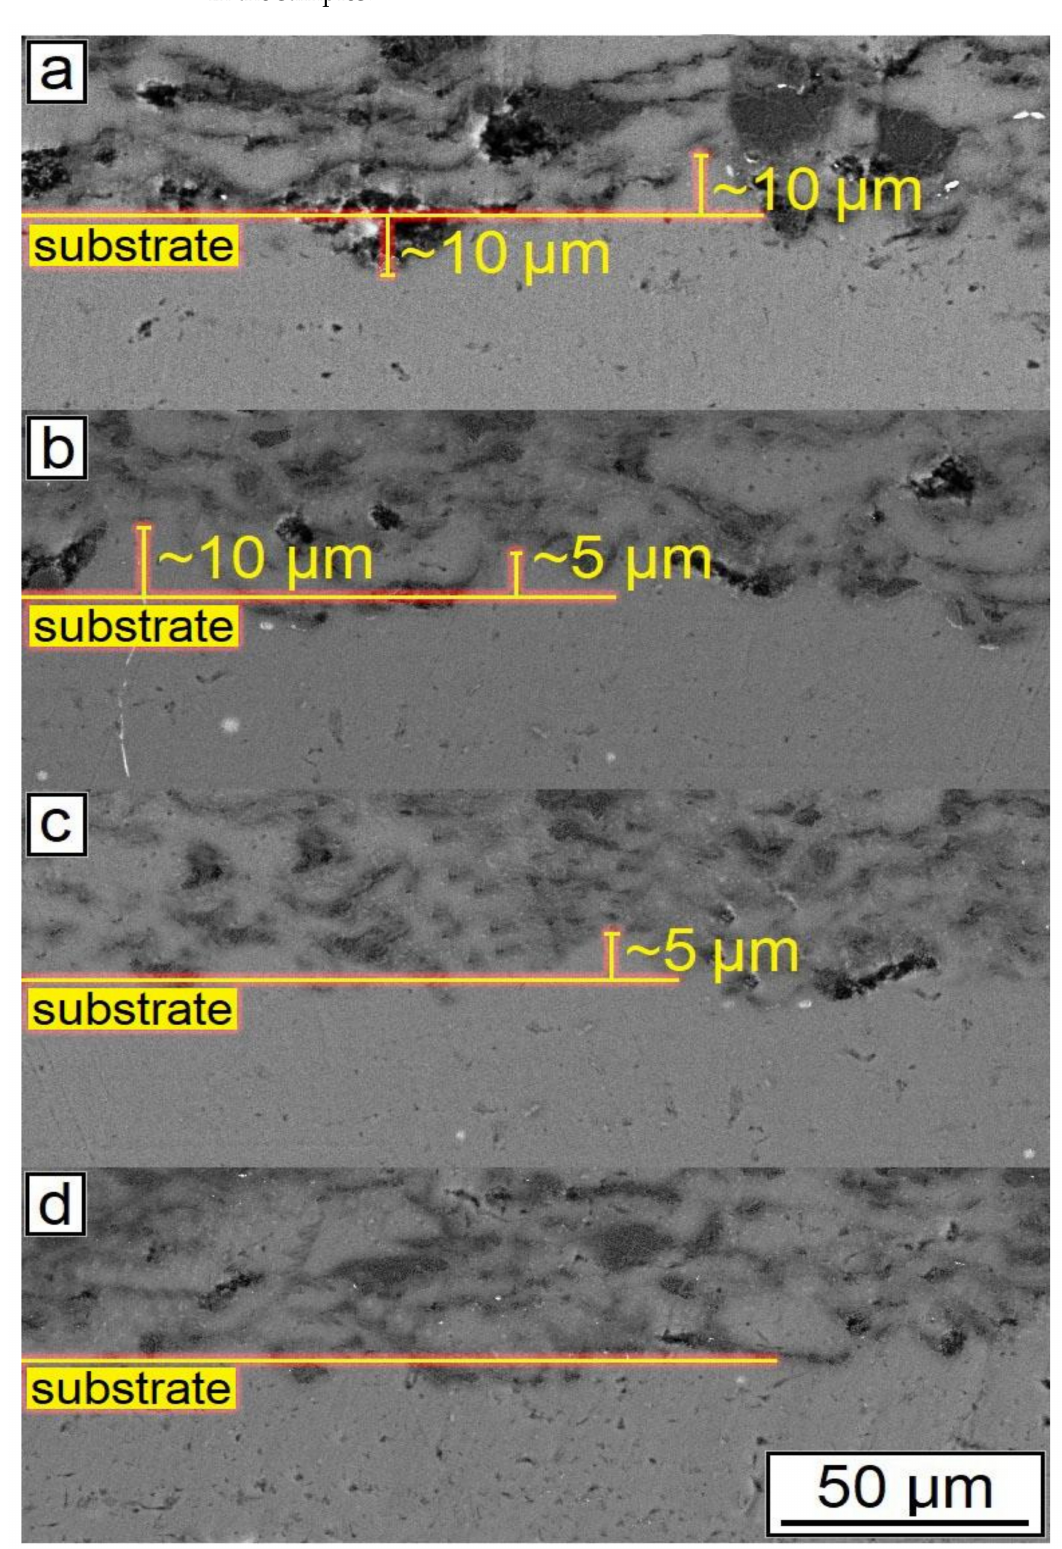
Figure 7. SEM results of the synthesized samples: ( a ) 30% Al + 70% Al 2 O 3 ; ( b ) 29.5% Al + 70% Al 2 O 3 + 0.5% CNF; ( c ) 29% Al + 70% Al 2 O 3 + 1.0% CNF; ( d ) 28.5% Al + 70% Al 2 O 3 + 1.5%